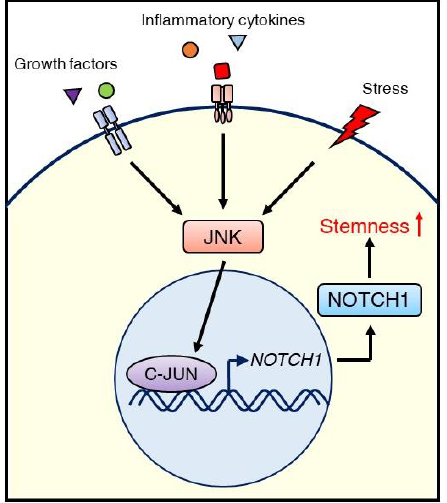
Figure 4 . Schematic illustrating the regulation of CSCs via the JNK/C-JUN/NOTCH1